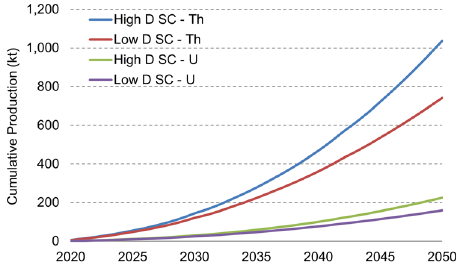
Fig. 6 Thorium and uranium production. Cumulative production of the coproduced metals thorium and uranium in the high and low demand